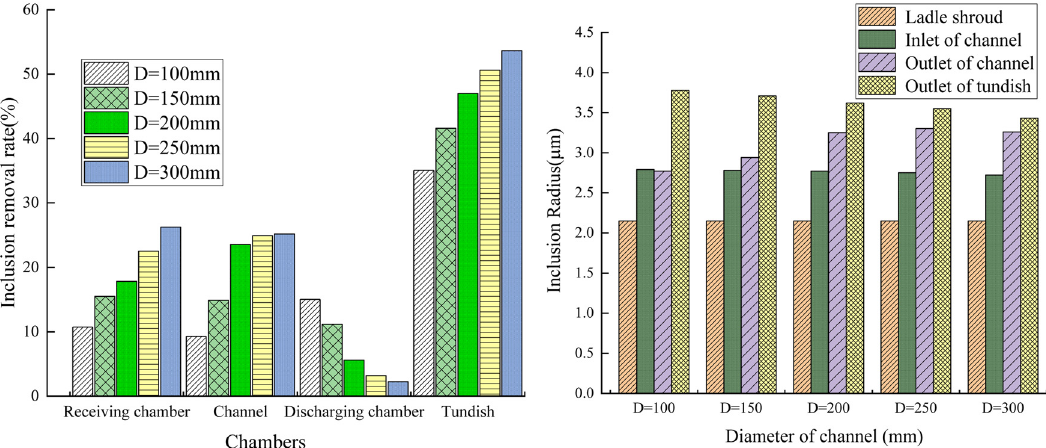
Figure 3: The inclusion removal rate in chambers and characteristic inclusion radius distribution at di ff erent positions for di ff erent